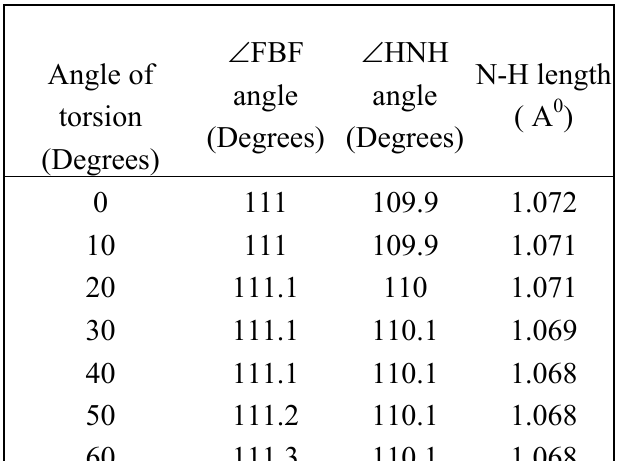
B–NH system as a function of torsional 3 3